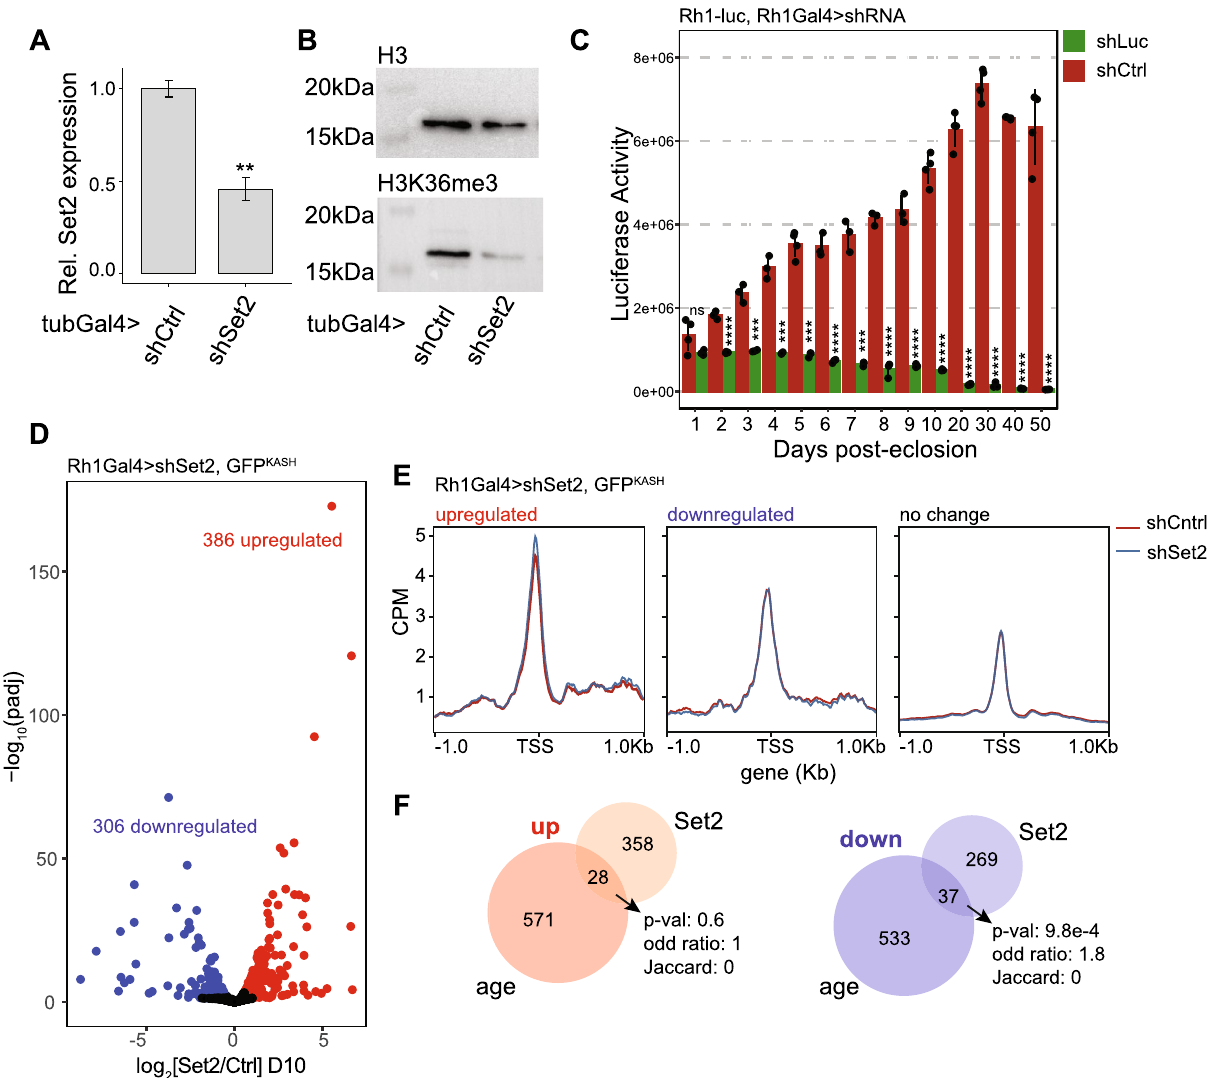
Figure 3. Photoreceptor transcriptome response to Set2 knockdown. ( A ) Bar plot showing qPCR analysis of Set2 transcript levels in larvae expressing a shRNA against Set2 (shSet2) or mCherry (shCtrl) under tubGal4 control (mean ± sdev; n = 3). Set2 transcript levels were normalized to the geometric mean of two reference genes (**p < 0.05, t -test). ( B ) Western blot showing H3K36me3 and H3 levels in shSet2 and shCtrl larvae, as in panel ( A ). ( C ) Bar plot showing luciferase activity in heads from Rh1-luciferase expressing flies that also express a shRNA against luciferase (shLuciferase) or shCtrl under Rh1Gal4 control at the indicated ages in days post- eclosion (mean ± sdev with dots representing individual biological replicates; ns not significant, ***p < 0.001, ****p < 0.0001, t -test, n = 3). ( D ) Volcano plot illustrating genes that were identified as differentially expressed in photoreceptors expressing shSet2 relative to shCtrl. ( E ) Gene metaplots of ATAC-seq signal in shSet2 and shCtrl photoreceptors in which genes are classified based on their differential expression status in the Set2 knockdown, as described in panel ( D ). ( F ) Venn diagram representing the overlap of genes that were differentially expressed (up- or down-regulated) in either aging (D40 vs D10) or upon loss of Set2 (shSet2 vs shCtrl). Overlap significance was obtained using a hypergeometric test with Jaccard index and Odds ratio are measurements representing